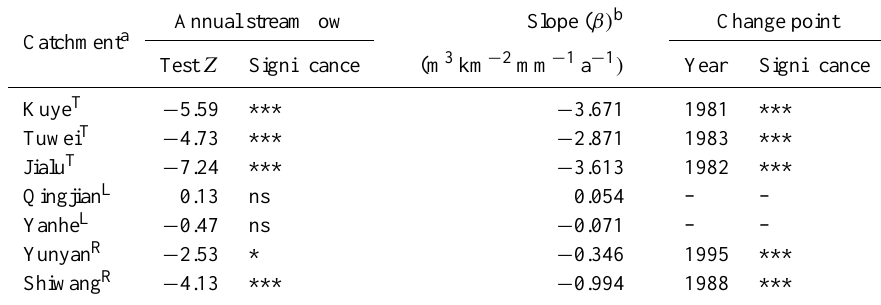
Table 3. Trends of the annual streamflow and change points by the Mann-Kendall and Pettitt